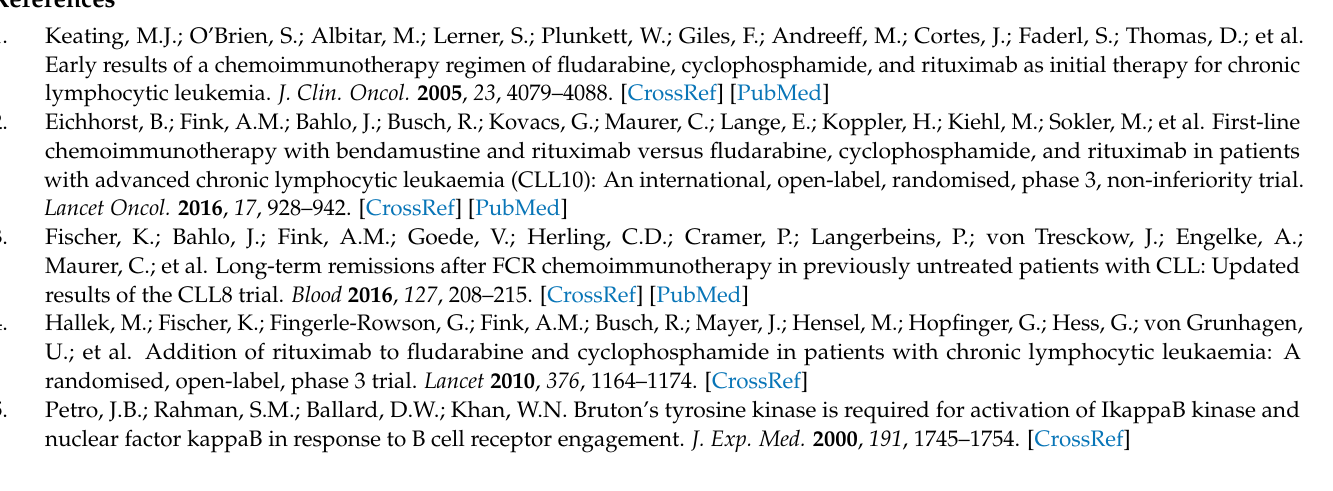
Table S1: Hepatitis B virus reactivation; Table S2: Univariate logistic regression analysis for baseline factors associated with permanent discontinuation, toxicity-related permanent discontinuation, and grade ≥ 3